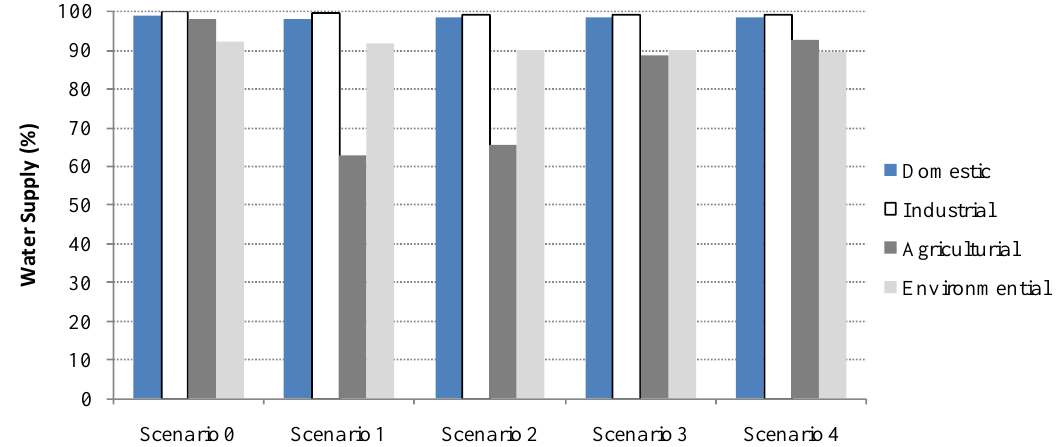
Figure 6. The amount of water demand supply (percent) of Hamoon- Jazmorian in different